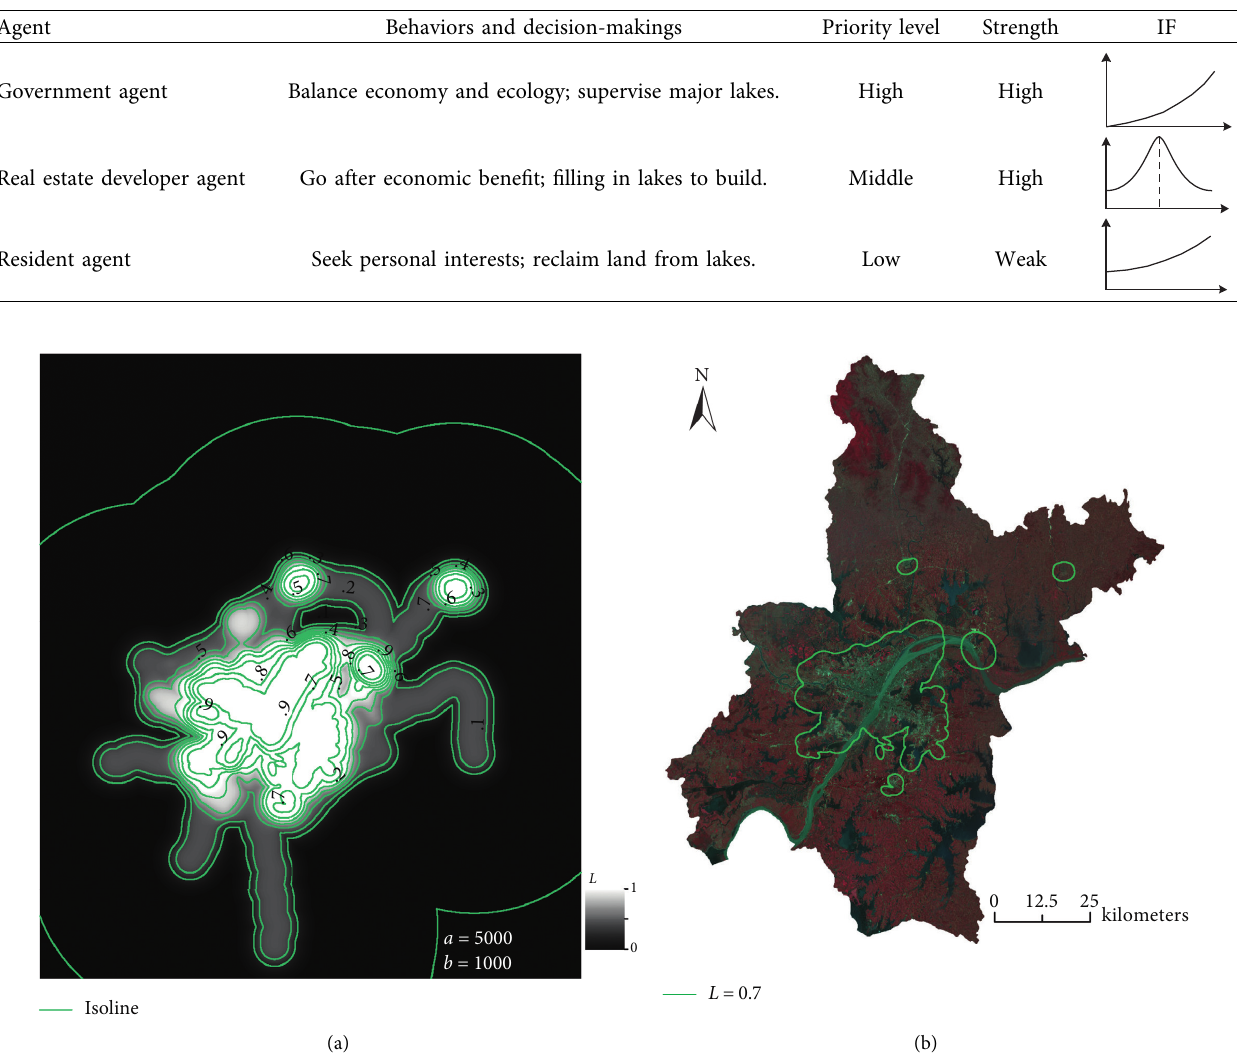
Figure 12: (a) A series of isolines from L . (b) The urban border is the isoline L � 0 . 7.